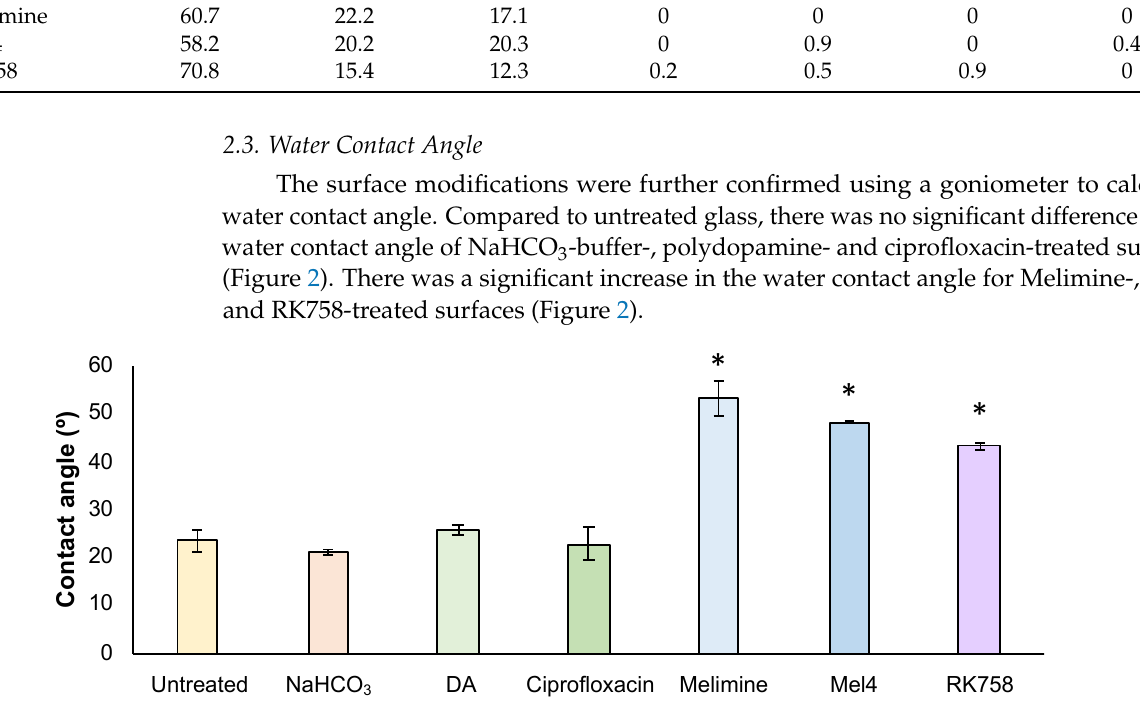
Figure 2. Water contact angle of treated surfaces. Data represent mean ± SD, n = 3. DA = polydopamine. Statistical analysis was conducted on GraphPad Prism v9 using a one-way ANOVA with Dunnett’s multiple comparisons test. * represents statistical difference to DA treatment group, p < 0.05.